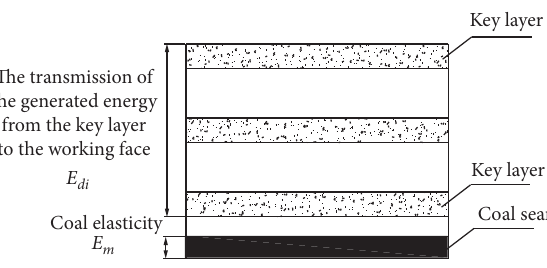
Figure 2: Energy characteristics model of gas coal rock